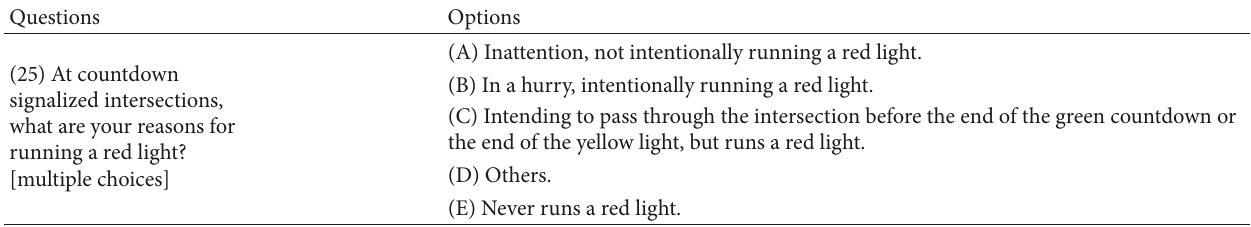
Table 7: Reasons for running a red light at countdown signalized